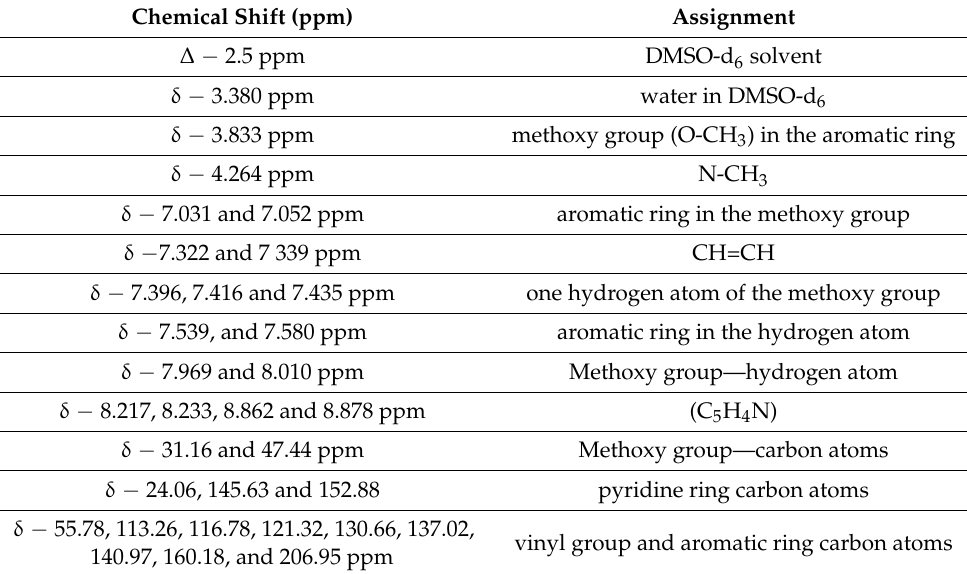
Figure 7. 13 C NMR for MMPI crystal. Table 4. Proton and carbon NMR chemical shift of MMPI